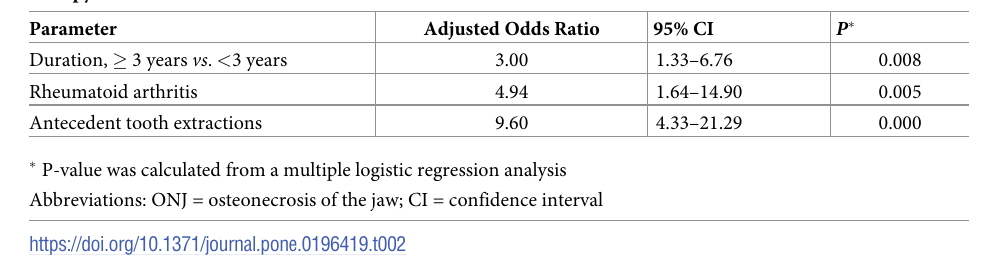
Table 2. Risk factors for the development of osteonecrosis of the jaw (ONJ) in patients receiving alendronate